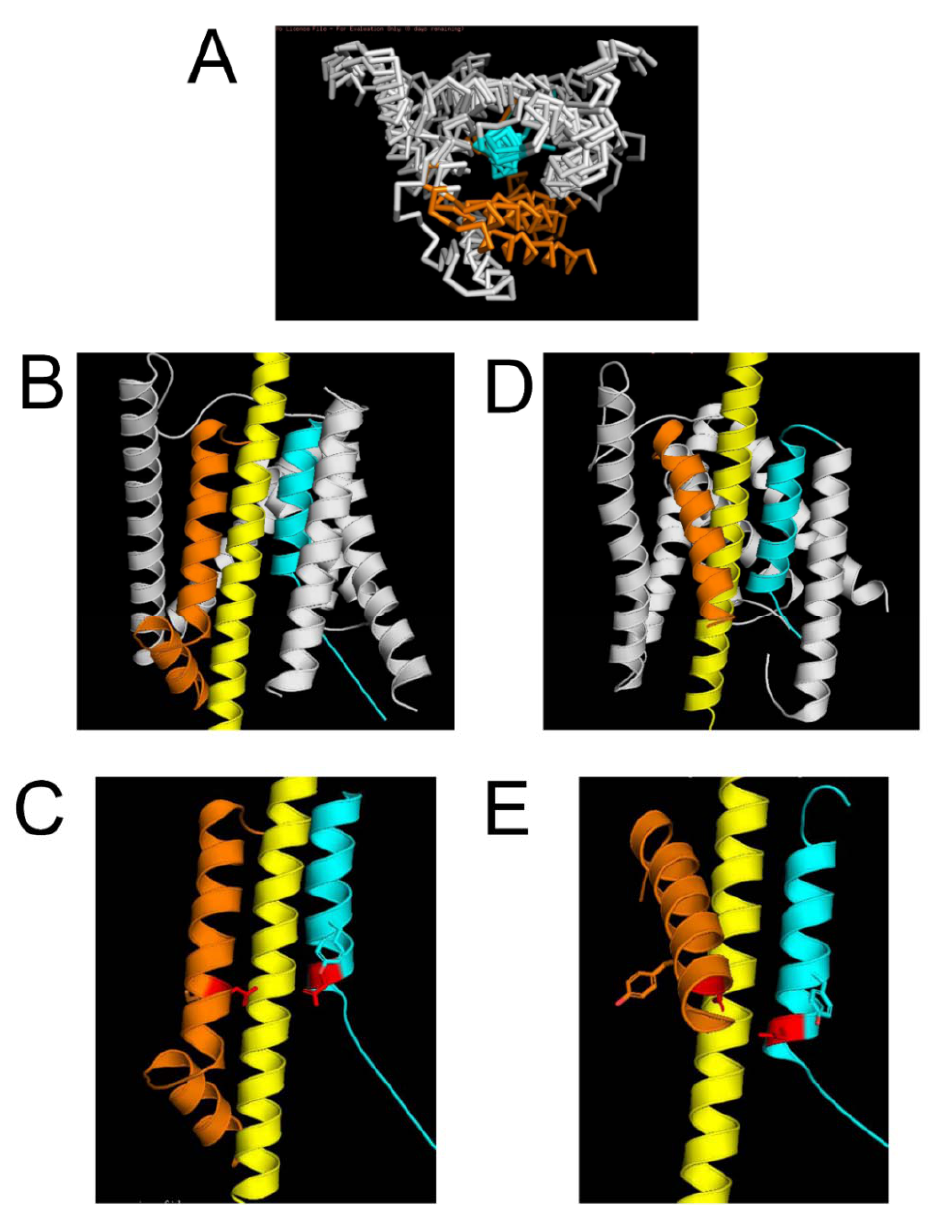
Figure 2. Structural models of the γ -secretase/APP complex. ( A ). An overlay of PS1 structures (PDB 5FN4, 5FN5, 6IYC). TM7 is colored in cyanate, and TM6 is colored in orange. All other TMs are colored in grey. ( B , C ). M1 model of the γ -secretase complex with APP. D1-TM6 region is colored in orange, TM7 is colored in cyanate, and APP is colored in yellow. Boundaries of the D1 region are shown in Figure 3. Only D1-TM6, TM7, and APP are shown in Panel C for clarity. Catalytic aspartates are colored in red. ( D , E ). M2 model of the γ -secretase complex with APP. TM6 region is colored in orange, D2-TM7 is colored in cyanate, and APP is colored in yellow. Boundaries of the D2 region are shown in Figure 3. Only D1-TM6, TM7, and APP are shown on Panel E for clarity. Catalytic aspartates are colored in